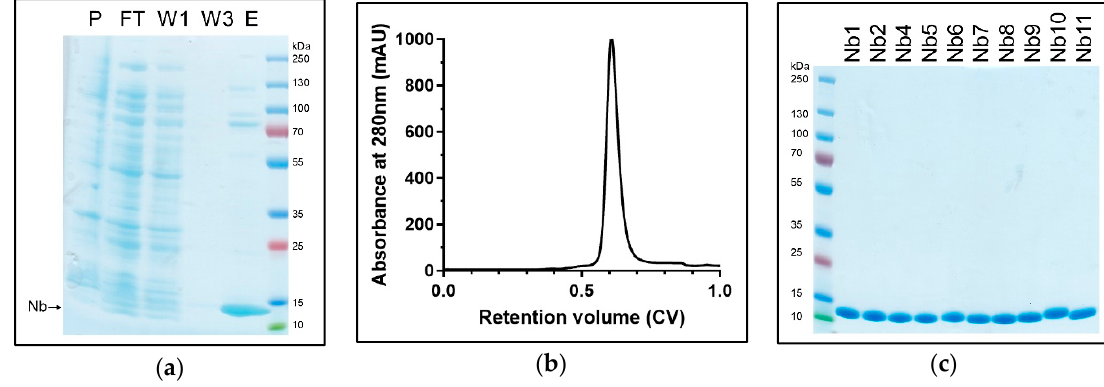
Figure 5. Nanobody purification. Samples from purification of Nb1 are representative of all the assessed Nbs. ( a ) Samples from insoluble fraction (pellet, P), flow-through of the IMAC (FT), first and third wash of Ni 2+ -beads (W1 and W3, respectively), and eluted fraction containing Nb1 loaded on Coomassie-stained SDS-PAGE. ( b ) SEC (24mL, Superose75) elution profile: The main peak elutes at 0.6 CV with only minor contaminants. ( c ) Coomassie-stained SDS-PAGE of SEC-purified Nbs: Nbs have a molecular weight of approximately 13.5 kDa.